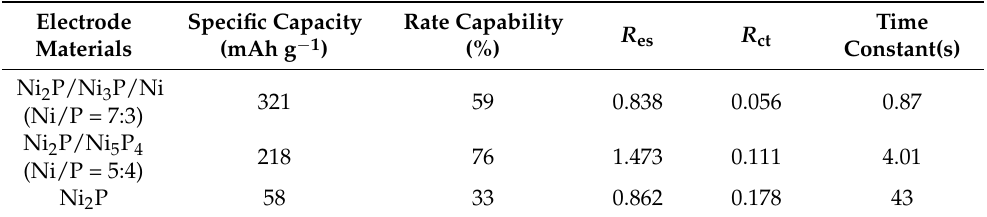
Figure 7. The electrochemical test graph of Ni 2 P/Ni 3 P/Ni (Ni/P = 7:3), Ni 2 P/Ni 5 P 4 (Ni/P = 5:4), and single-phase Ni 2 P. ( a ) Galvanostatic charge-discharge curves of Ni 2 P/Ni 3 P/Ni (Ni/P = 7:3), Ni 2 P/Ni 5 P 4 (Ni/P = 5:4), and single-phase Ni 2 P at 1 A g − 1 . ( b ) Cyclic voltammetry curves of Ni 2 P/Ni 3 P/Ni (Ni/P = 7:3), Ni 2 P/Ni 5 P 4 (Ni/P = 5:4), and single-phase Ni 2 P at a sweep rate of 3 mV s − 1 . ( c ) Nyquist plots of Ni 2 P/Ni 3 P/Ni (Ni/P = 7:3), Ni 2 P/Ni 5 P 4 (Ni/P = 5:4), and single-phase Ni 2 P. ( d ) Bode plots of Ni 2 P/Ni 3 P/Ni (Ni/P = 7:3), Ni 2 P/Ni 5 P 4 (Ni/P = 5:4) and single-phase Ni 2 P. Table 2. The electrochemical performance of Ni 2 P/Ni 3 P/Ni (Ni/P = 7:3), Ni 2 P/Ni 5 P 4 (Ni/P = 5:4), and single-phase nickel phosphide.